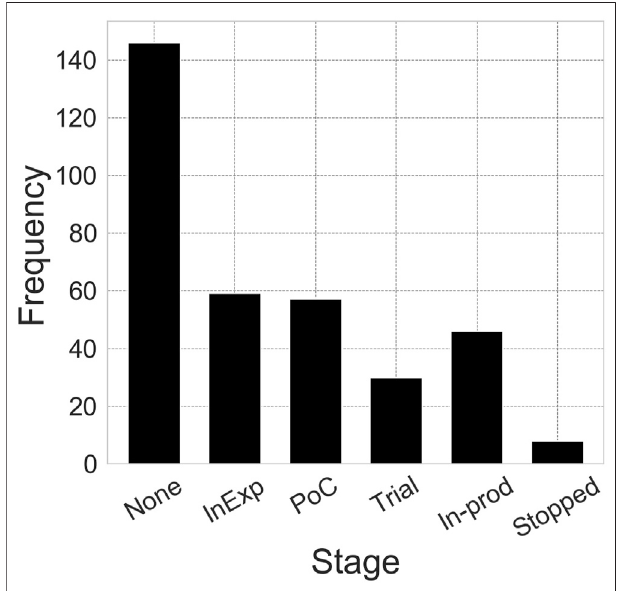
FIGURE 5 | Distribution of